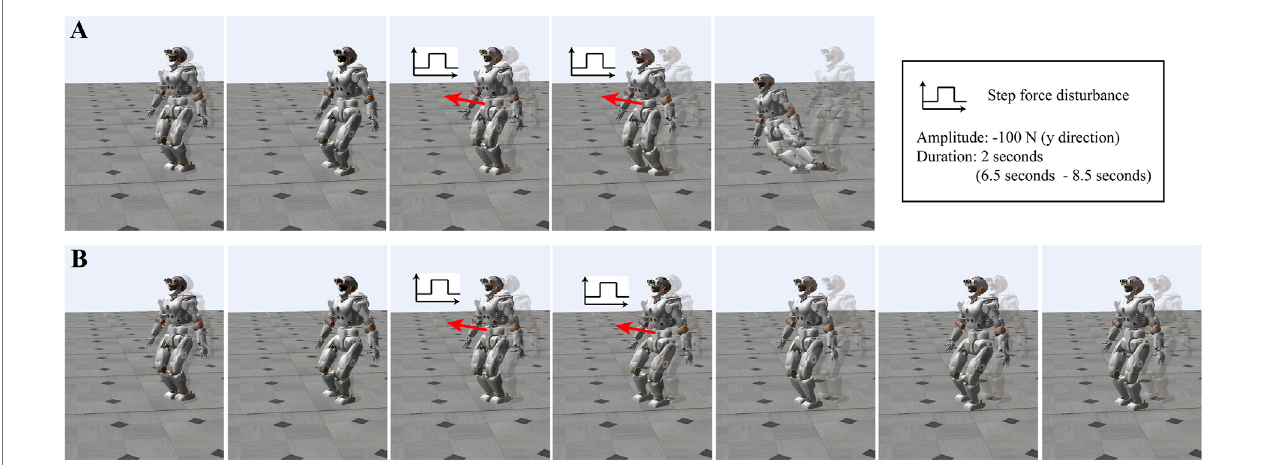
FIGURE10| Snapshotsofsimulationsfor walkingwhile anexternalforce exists: (A) walking withouttheproposedgainadaptation, (B) walkingwiththeonlinegain adaptation.